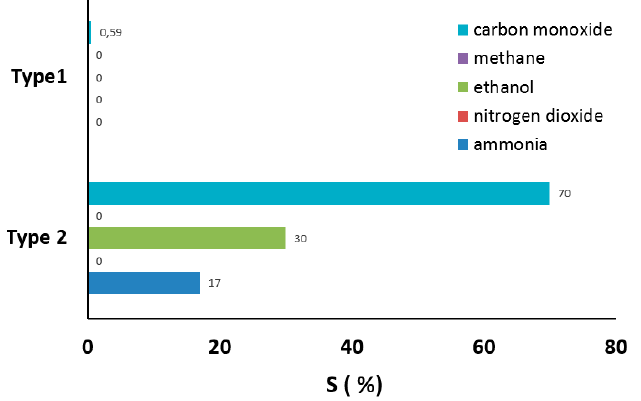
Figure 10. Sensors response towards 16 ppm of different gases at 200 °C (type-1 (film, doped with CuO) and 250 °C (type-2 (film, doped with CuO)).